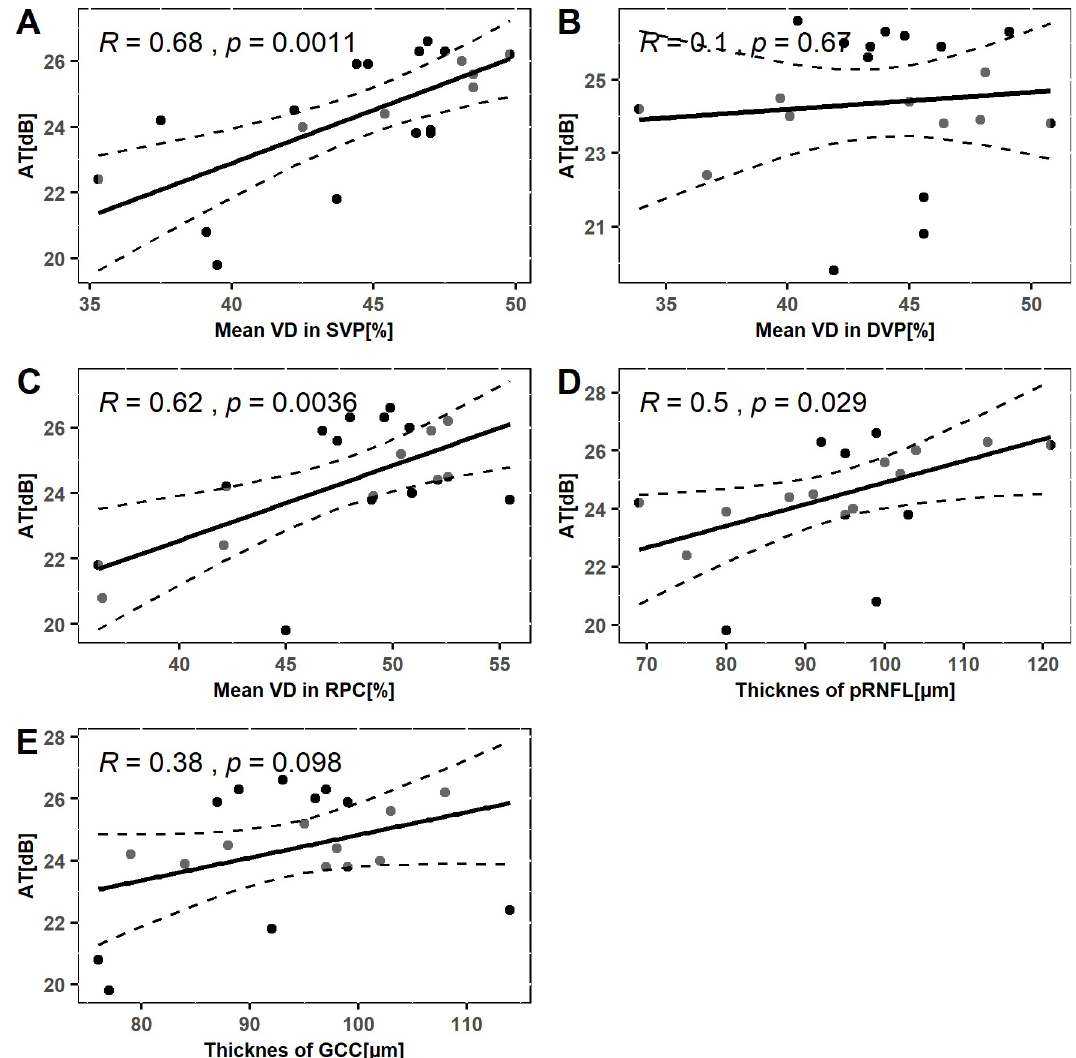
Fig 4. The scatter plots show the Pearson’s correlation coefficient measuring the relationship between. A) average threshold of the retinal sensitivity and mean vessel density in superficial vascular plexus; B) average threshold of the retinal sensitivity and mean vessel density in deep vascular plexus; C) average threshold of the retinal sensitivity and mean vessel density in radial peripapillary capillaries; E) average threshold of the retinal sensitivity and thickness of peripapillary retinal nerve fiber layer; F) average threshold of the retinal sensitivity and thickness of ganglion cell complex; of eyes after scleral buckling surgery for macula-on retinal